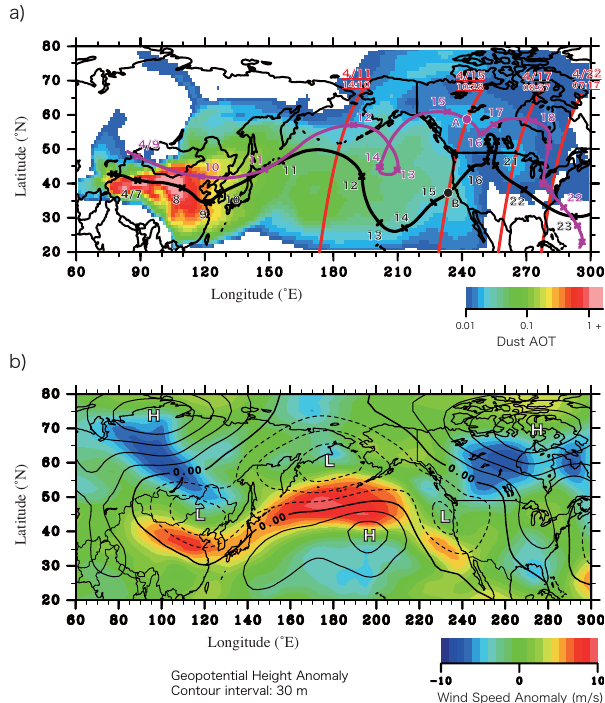
Fig. 3. (a) Averaged dust AOT (color) and two HYSPLIT trajecto- ries (black A and pink B) beginning at CALIPSO orbit points (15 April). Red lines indicate CALIPSO orbit paths. Numbers on tra- jectories show the date in April 2010. (b) Anomaly in 500-hPa geopotential height (contour) and wind speed (color) in April at